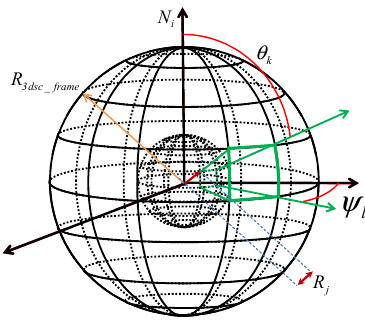
Figure 6. Three-dimensional shape context (3DSC) feature space division.